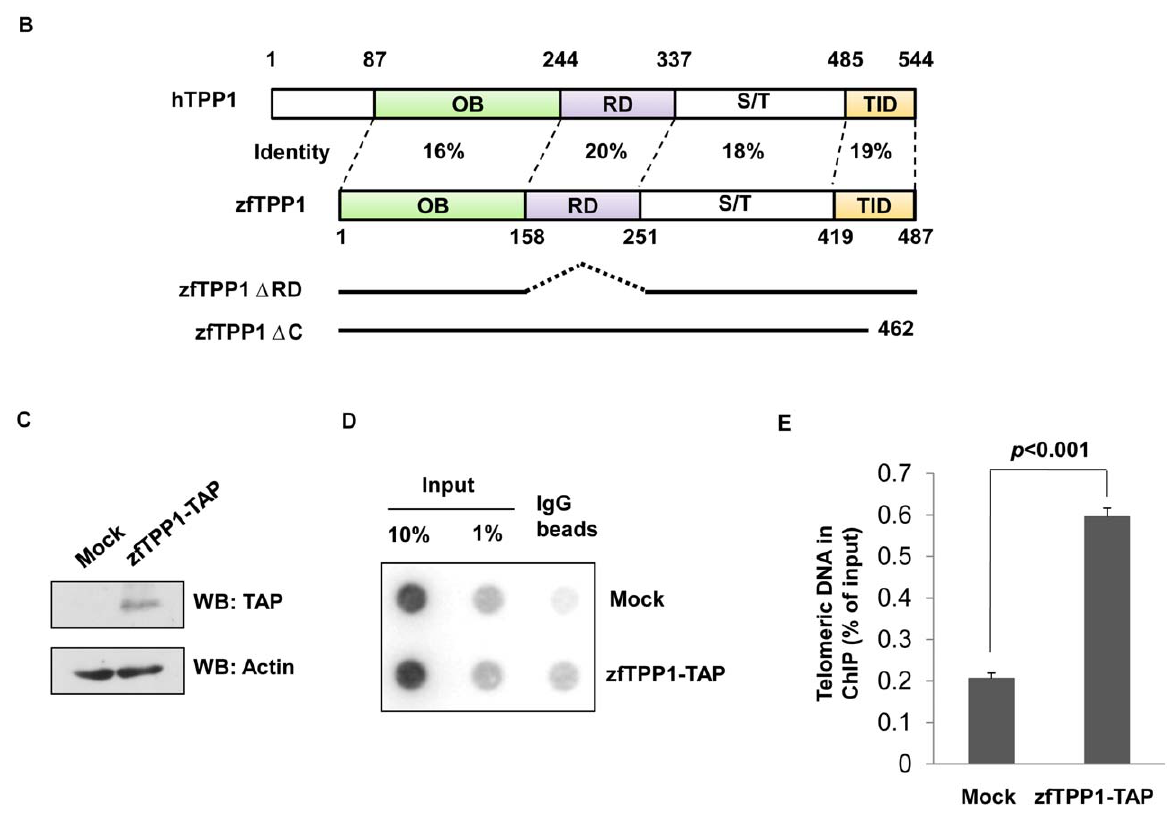
Figure 2. Characterization of zfTPP1. (A) Schematic representation of domain organization of human and zebrafish TPP1. OB, oligonucleotide/ oligosaccharide binding fold. RD, POT1 recruitment domain. S/T, Serine-rich region. TID, TIN2-interacting domain. (B) Expression of TAP-tagged zfTPP1 in zebrafish cells. Whole cell extracts from parental and TAP-tagged zfTPP1 expressing zebrafish cell line ZF4 were western blotted with peroxisome-conjugated protein A. Actin was used as a loading control. (C) Telomere association of zfTPP1. Parental and TAP-tagged zfTPP1 expressing ZF4 cells were crosslinked and used for chromatin immunoprecipitation with protein A beads. The precipitated DNA was analyzed by southern blotting. (D) Quantification of data in D. Error bars indicate standard error